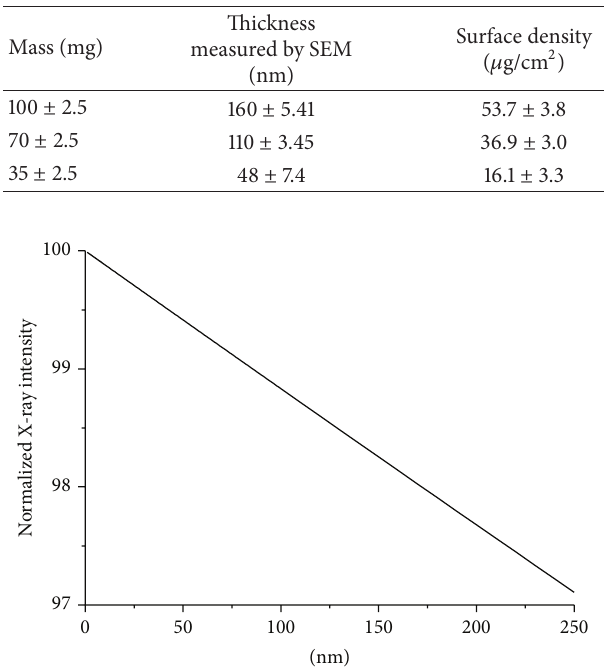
Figure 5: Theoretical attenuation according to (1) for the Ca-K 𝛼 (3.69 keV) through the vanadium film.